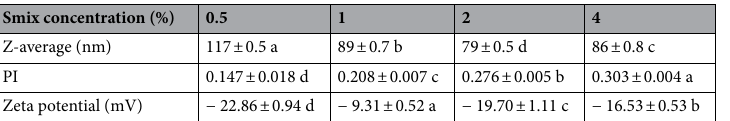
Table 4. Z-average (particle diameter), PI, and zeta potential of CEO-based nanoemulsions incorporating different concentrations of Smix at HLB 14. Means ± standard deviations. Means with different letters within a row are significantly different ( p < 0.05).